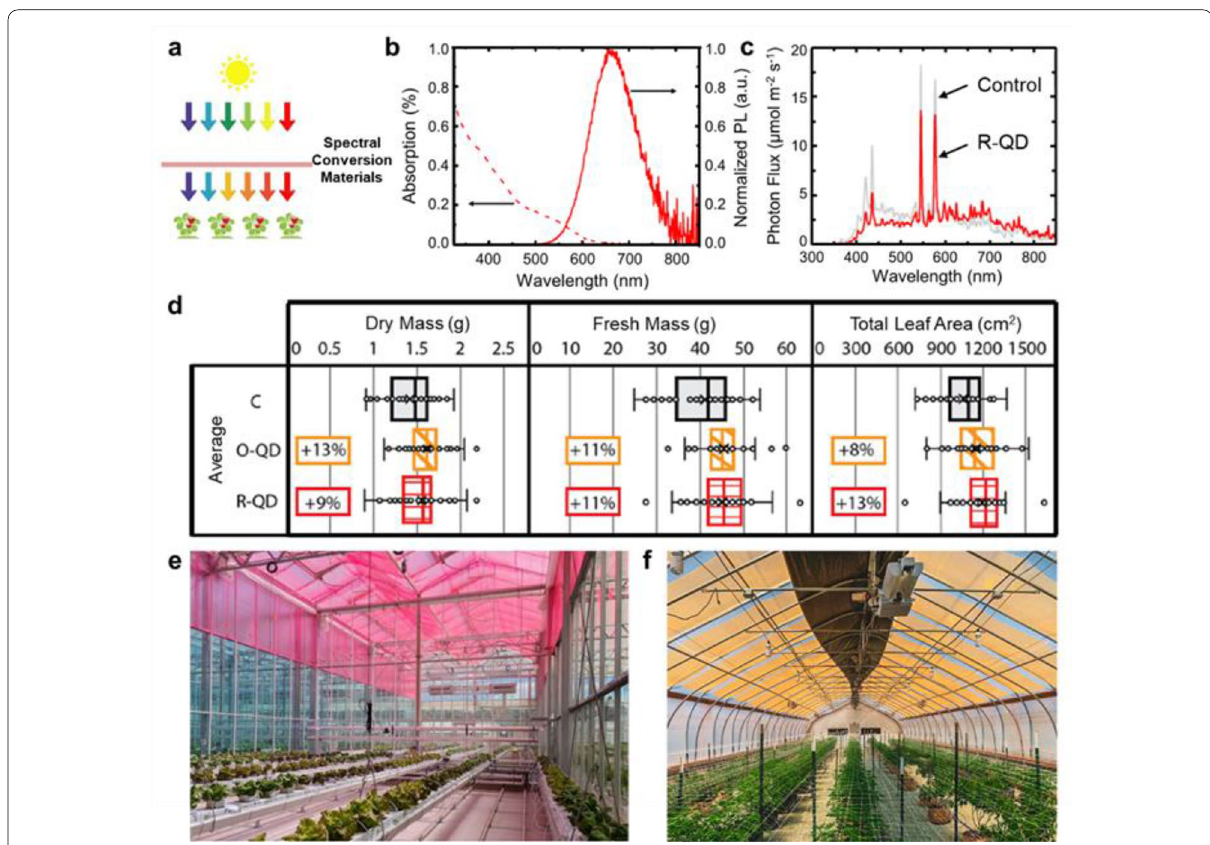
Fig. 3 a Schematic illustration of spectral conversion materials in a greenhouse setting for enhancing plant growth. b Percent absorption and normalized PL emission for CuInS 2 (CIS)/ZnS quantum dots (QDs)-doped film with peak emissions centered at 660 nm (R-QD). c Measured spectra beneath the R-QD film and the control film without QDs. d Experimental results of measured edible dry mass, edible fresh mass, and total leaf area for three replicate red romaine lettuce experiments under control film, CuInS 2 (CIS)/ZnS QDs-doped film with peak emissions centered at 600 nm (O-QD) and R-QD film. b-d are replotted with permission from [43]. e Greenhouse covered with the commercially available red LLEAF films for the growth of leafy greens. Republished with permission from LLEAF (http:// www. lleaf. com. au/). f Greenhouse covered with the commercially available QDs-doped films. Republished with permission from Ubigro (https:// ubigro.